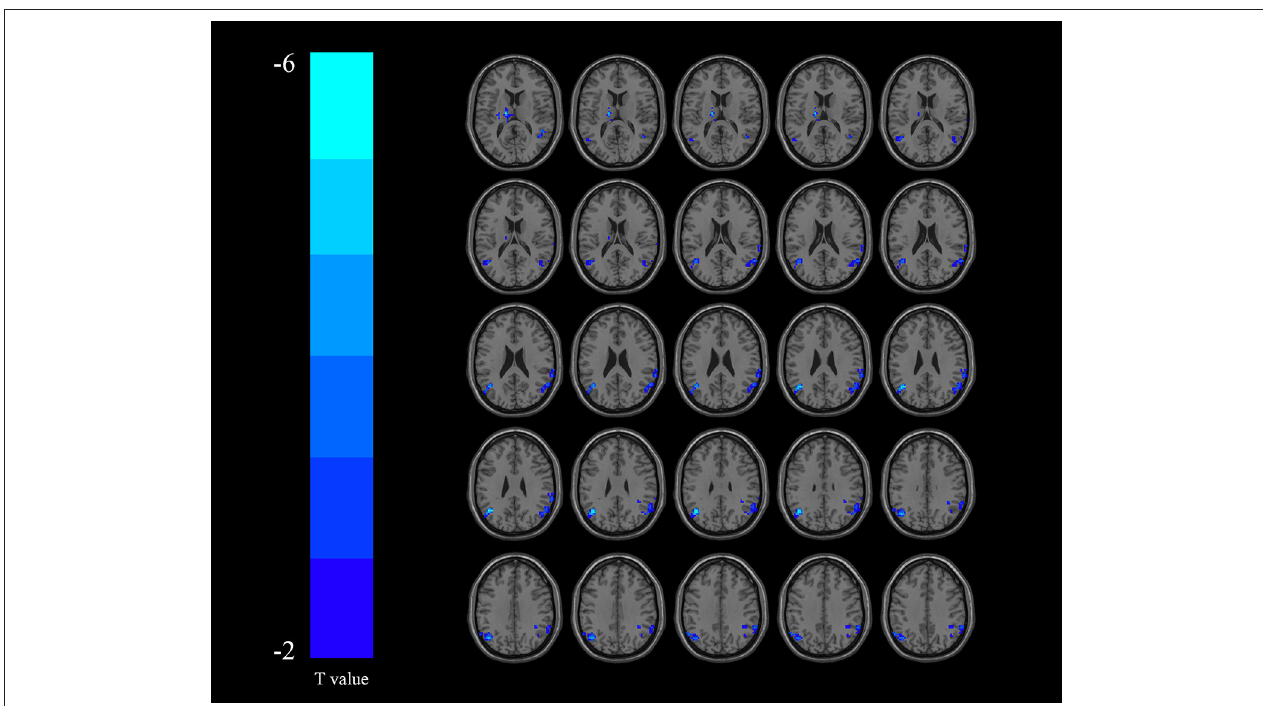
FIGURE 2 | Regions exhibiting differences in regional homogeneity (ReHo) between the dysphagia after cerebral infarction (DYS) and non-DYS groups [ p < 0.001 corrected by Gaussian random field (GRF)]. Cooler colors indicate significantly lower ReHo values in the DYS group.